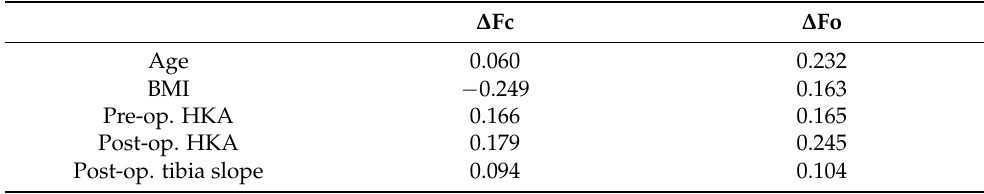
Table 4. Coefficient of correlation with ∆ flexion gap after